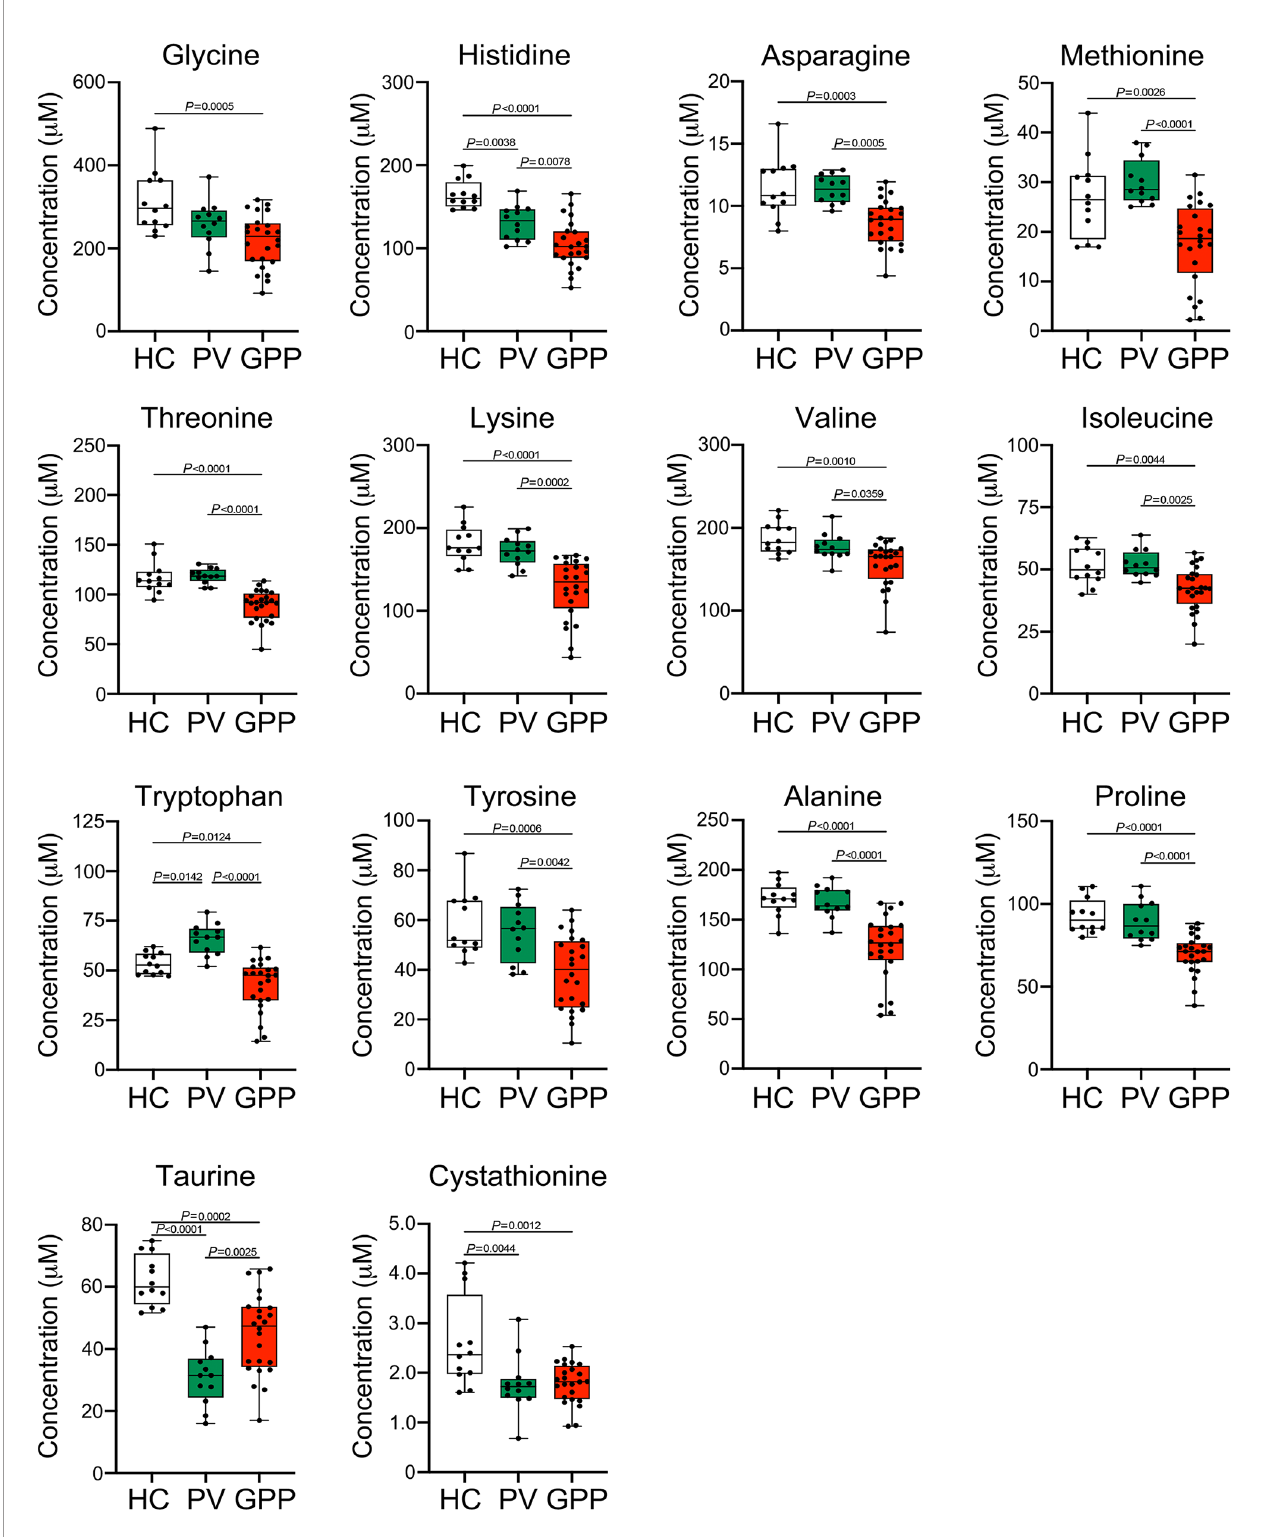
FIGURE 4 | Amino acid alterations in GPP serum identi fi ed by targeted metabolomics. Boxplot of the 14 differential amino acids including glycine, histidine, asparagine, methionine, threonine, lysine, valine, isoleucine, tryptophan, tyrosine, alanine, proline, taurine and cystathionine in GPP (n = 24), PV (n = 12) and HC (n =12) serum. Data are presented as mean ± SD, and are assessed by One-way ANOVA and Dunnett ’ s post hoc